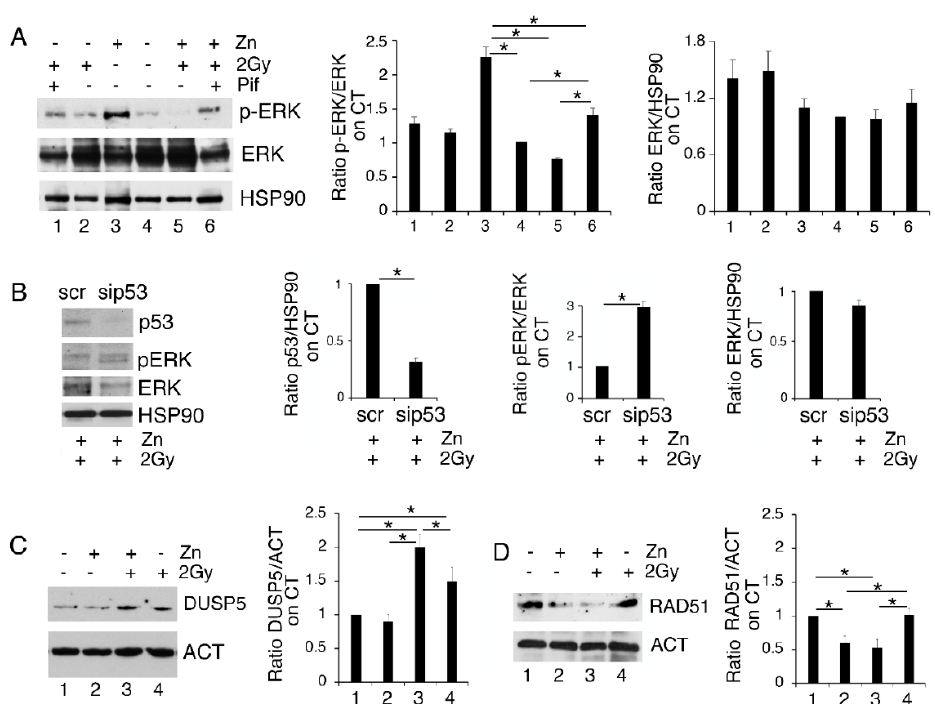
Figure 4. The activation of p53 is involved in ERK1/2 dephosphorylation in PEL cells treated with Zinc/radiation. ( A ) BC3 cells were treated with Zinc/2Gy radiation in the presence or in the absence of pifithrin- α (pif) and phospho- and total ERK1/2 were assessed by Western blot analysis; ( B ) BC3 cell were silenced for p53 and the expression of p53, phospho and total ERK1/2 were analyzed by Western blot; ( C , D ) BC3 cells treated with Zinc in combination or not with 2Gy radiation were analyzed in Western blot for the expression of DUSP5 or RAD51. Actin or HSP90 were used as loading control. Densitometric analysis was performed as reported in Material Methods. Histograms represent the mean plus SD of three different experiments, * p -value < 0.05.